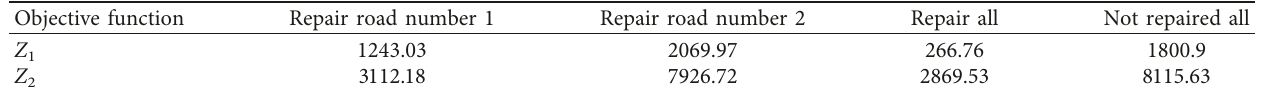
Table 7: Comparison of target values under four road networks.